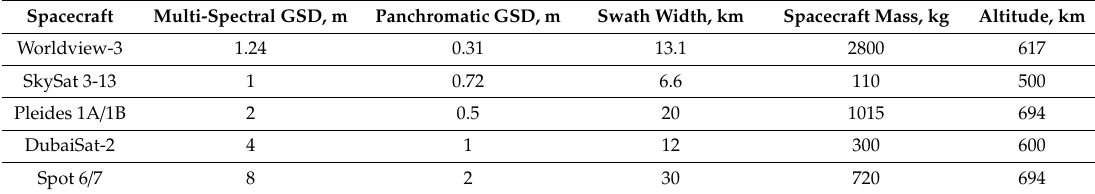
Table 2. Specifications for existing high-resolution satellite systems [21,27–29].